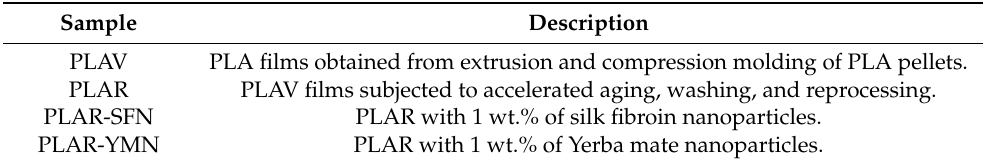
Table 1. Samples obtained after the mechanical recycling